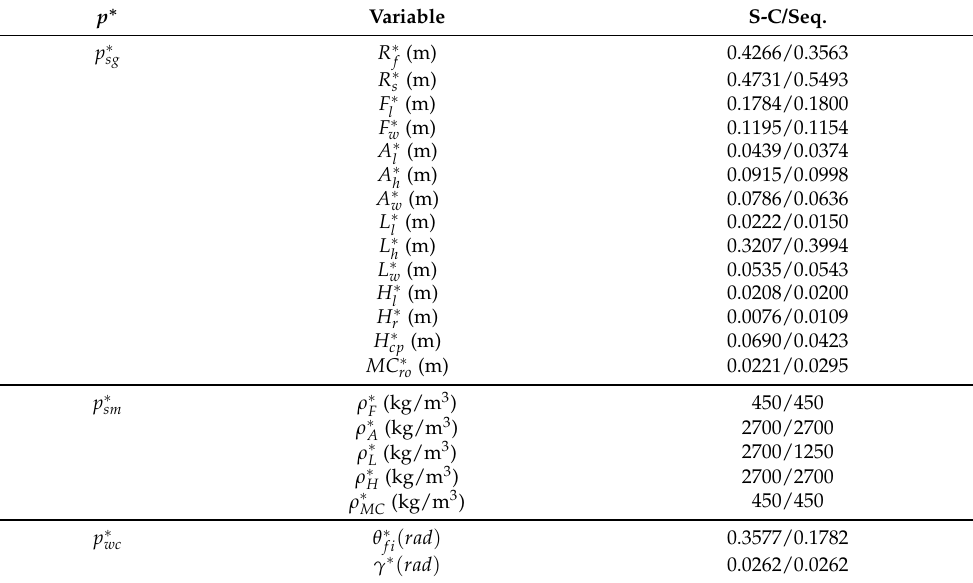
Figure 6. Evolution of the best S-C design execution: ( a ) Convergence of the mean value of the aggregate function J mean . ( b ) Convergence of the mean value of the violated constraints VC mean . Table 5. Optimal structure and walking condition design variables associated with the best solution obtained by structure-control (S-C) and sequential (Seq.) design processes.